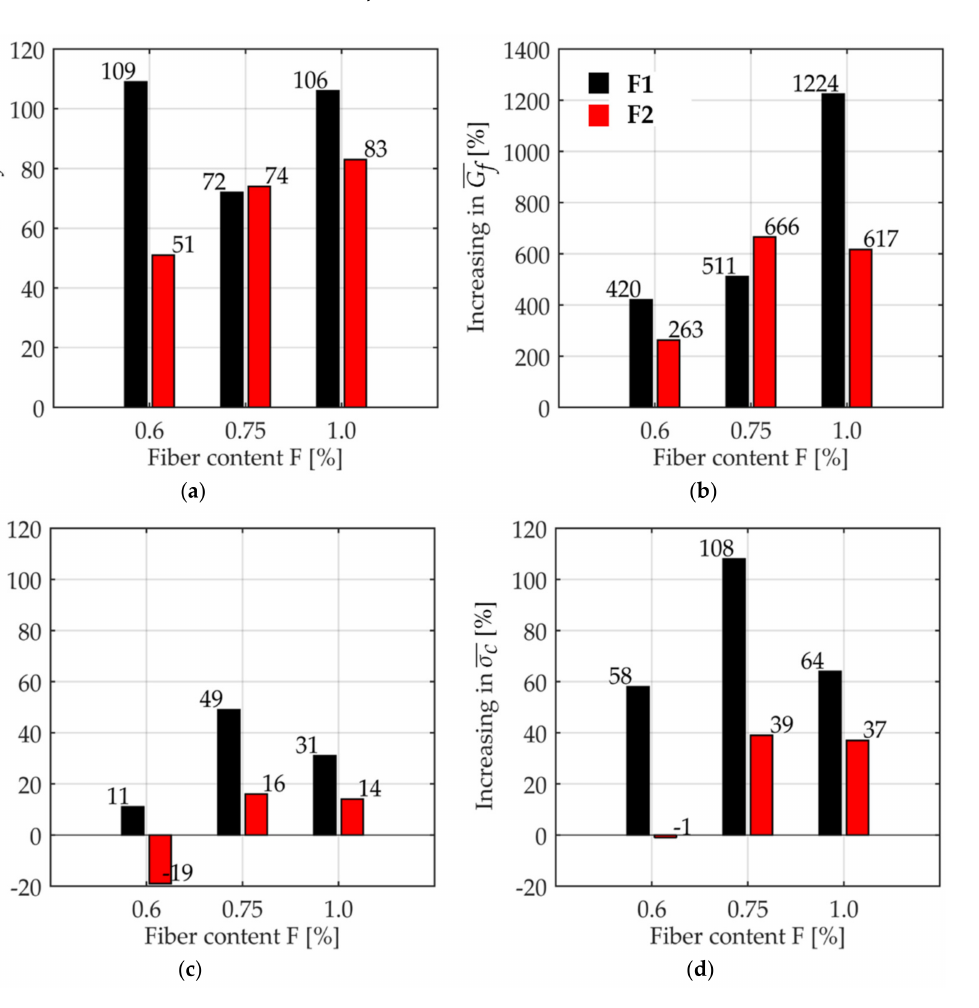
Figure 19. Increase of the mechanical properties in the case of, ( a ) bending strength σ f ; ( b ) fracture energy G f ; ( c ) tensile strength σ t and, ( d ) compressive strength σ c , with respect to the unstrengthened case for the three fiber contents F . The bars are coupled by type of fiber and are distinguished by color, black and red for the fibers F1 and F2, respectively, to simplify the